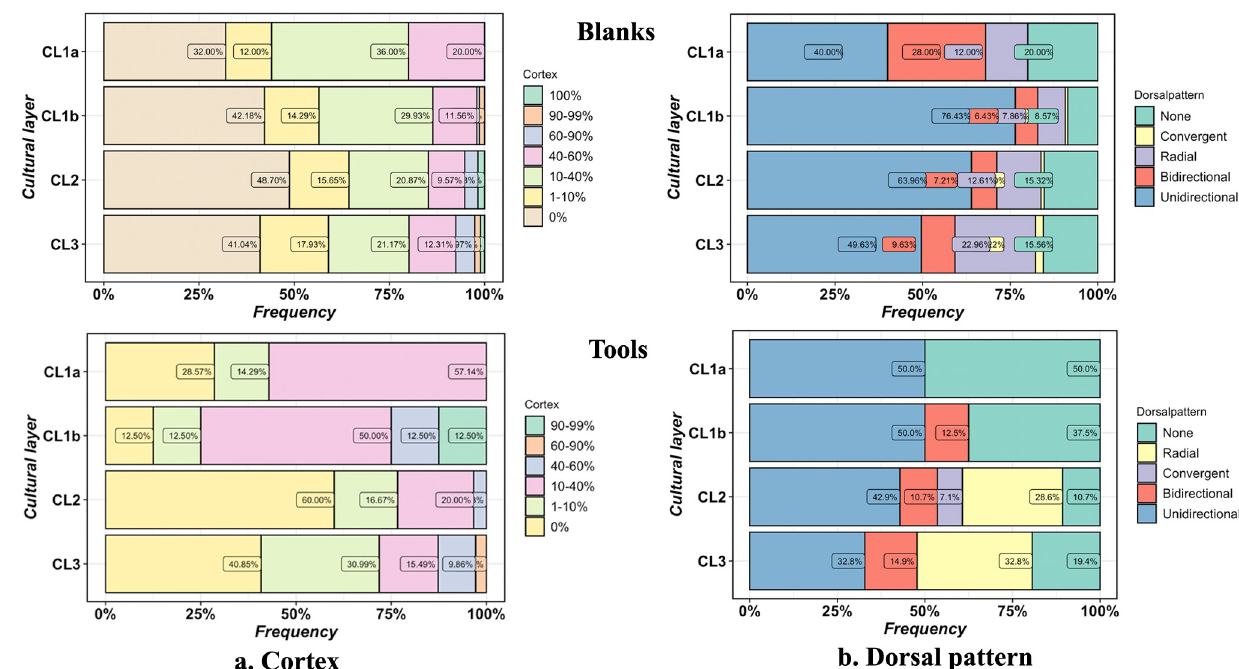
Fig 5. Cortex and dorsal pattern of flakes and tools.